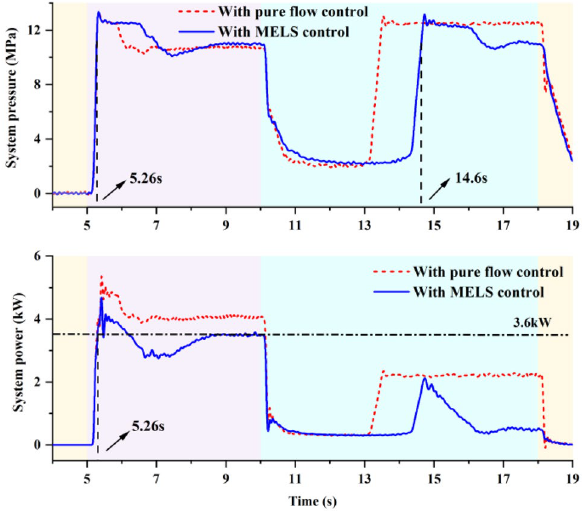
Figure 16 System pressure and system